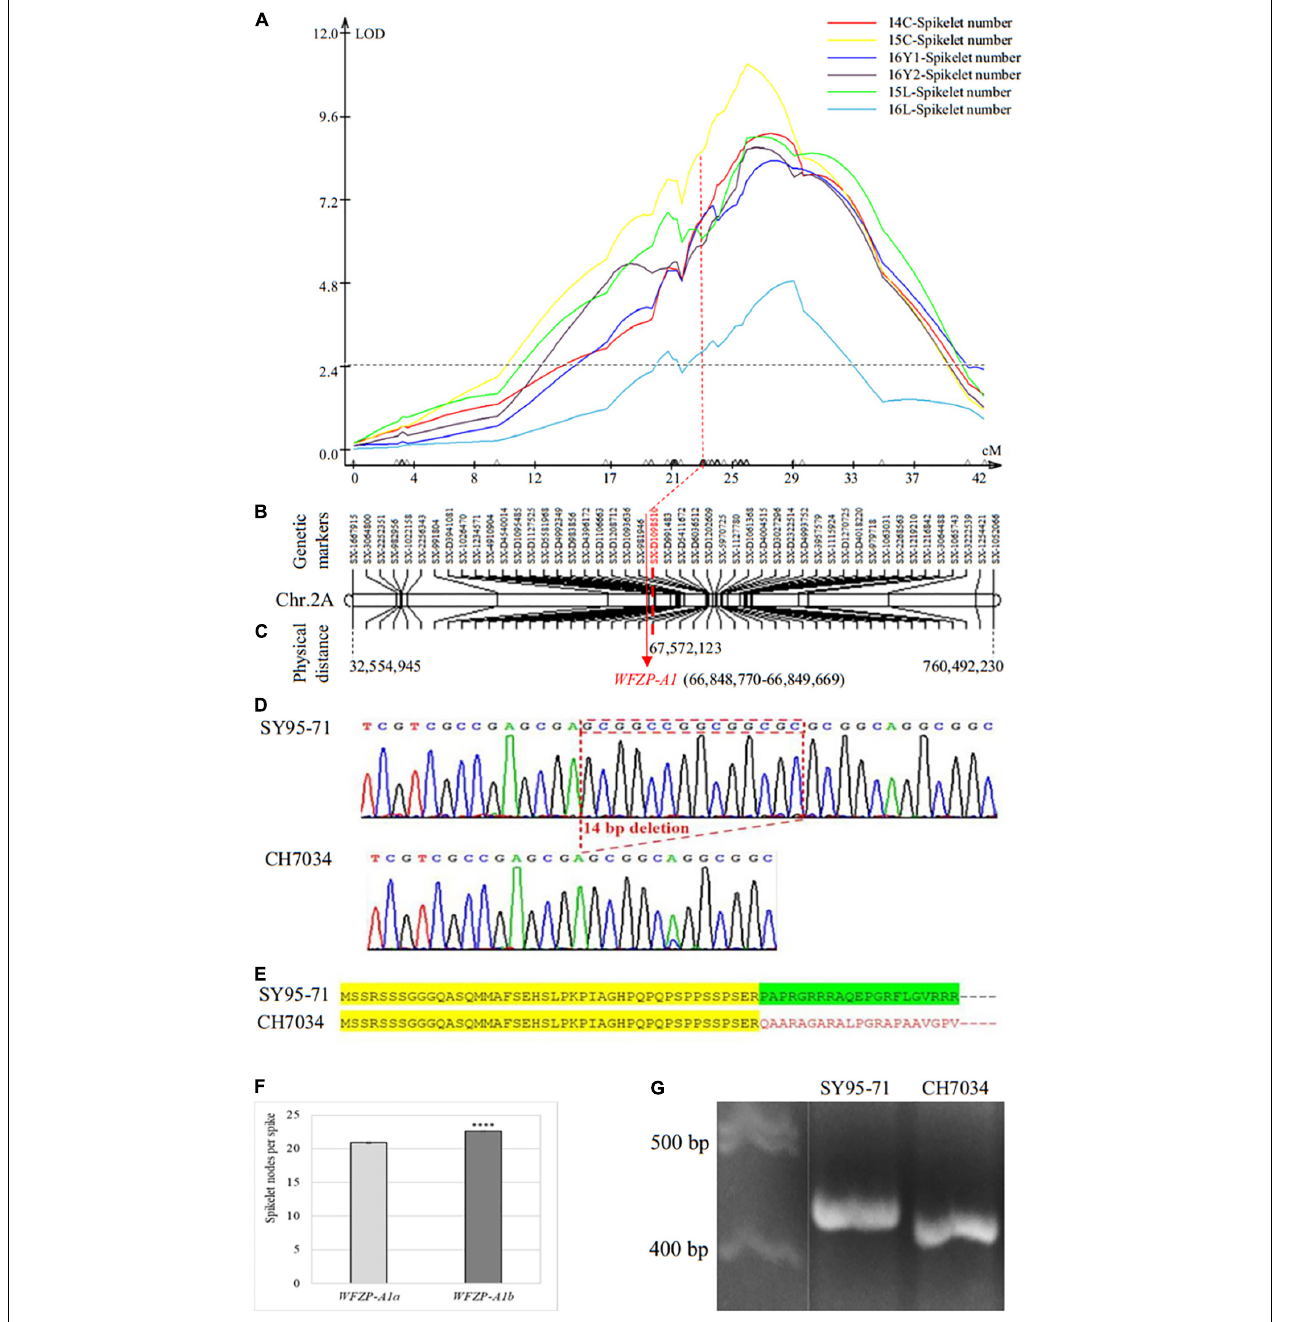
FIGURE 2 | Genetic and physical maps of SNS QTL QSns.sxau-2A and allelic variation in the candidate gene WFZP-A1 . (A) Mapping of the QSns.sxau-2A locus. The phenotypic data was collected in Chengdu in 2014 (14C) and 2015 (15C), two experimental locations in Yuncheng in 2016 (16Y1 and 16Y2), and Linfen in 2015 (15L) and 2016 (16L). LOD value is indicated on Y axis, and genetic distance (cM) is indicated on X axis. (B) Genetic map of QSns.sxau-2A . The SX plus 8-digit SNP codes are markers from SNP from 17K SNP chips, and the SX-D plus 8-digit SNP codes are markers from the 35K DArT chips. (C) Physical map of QSns.sxau-2A . The physical locations of markers and candidate gene WFZP-A1 are shown based on the Chinese Spring genome sequence of RefSeq v1.1. (D) Allelic variation in WFZP-A1. The 14-bp sequence that is placed in a red square is present in SY95-71 but absent in CH7034. (E) Deduced WFZP-A1 proteins in SY95-71 and CH7034. Conserved amino acids before the deletion in both SY95-71 and CH7034 are highlighted in yellow, functional amino acids after the deletion in SY95-71 are highlighted in green, and altered amino acids after the deletion in CH7034 are indicated in red. Dots indicate more amino acids toward to C terminus. (F) Comparison of SNS between the SY95-71 allele and the CH7034 allele. A t -test was performed to show significant level in SNS between the two alleles. The bars indicate standard error. “****” indicates significant difference ( p < 0.0001). (G) A diagnostic PCR marker for WFZP-A1 between the SY95-71 and CH7034. The marker was developed to distinguish between the SY95-71 allele without the 14-bp deletion and the CH7034 allele with the 14-bp deletion.